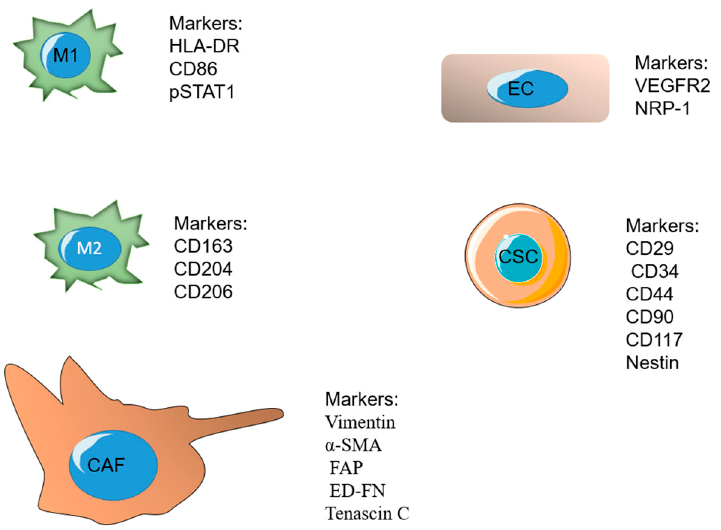
Figure 5. Some of the important present cells in the tumor microenvironment and their specific